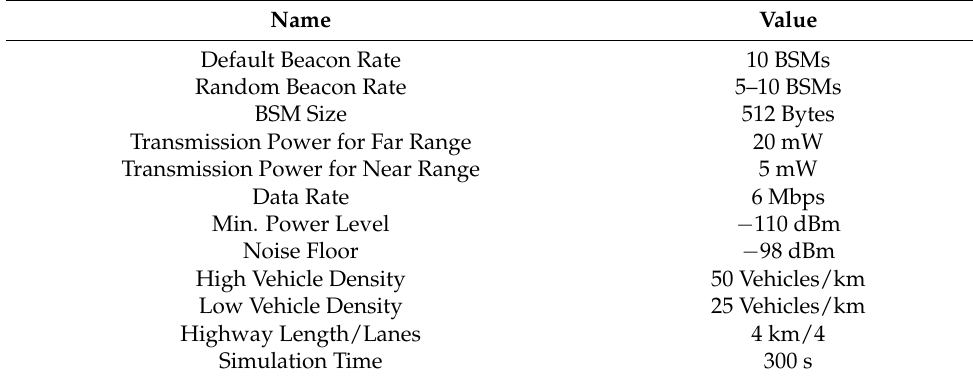
Table 2. Configuration